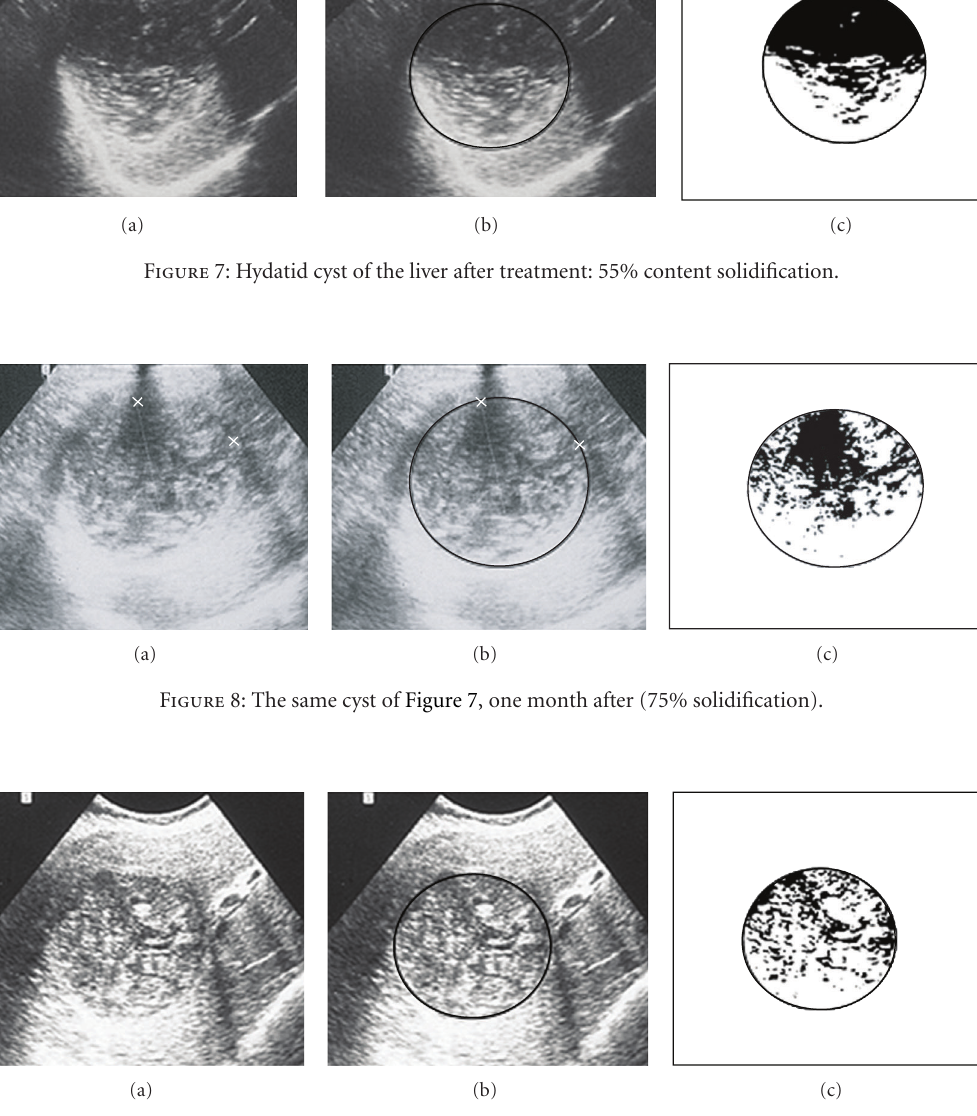
Figure 9: The same cyst of Figure 7, six month later (solidification >